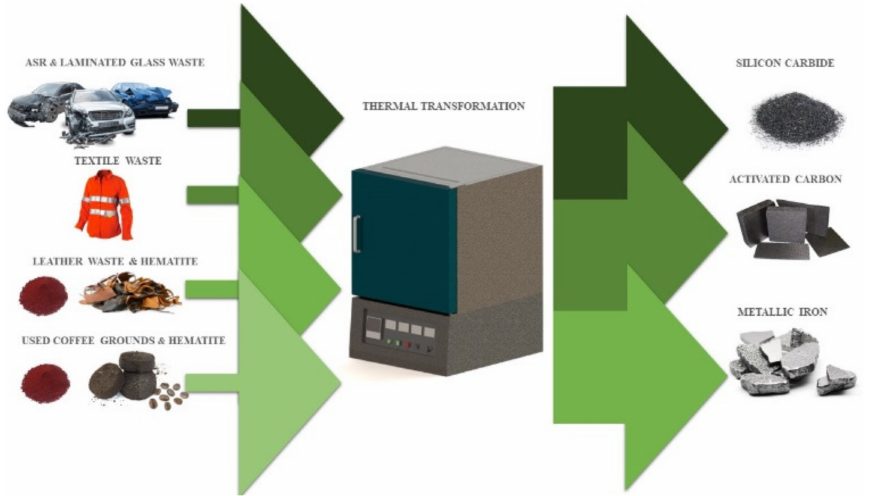
Figure 1. Thermal transformation of secondary resources of carbon